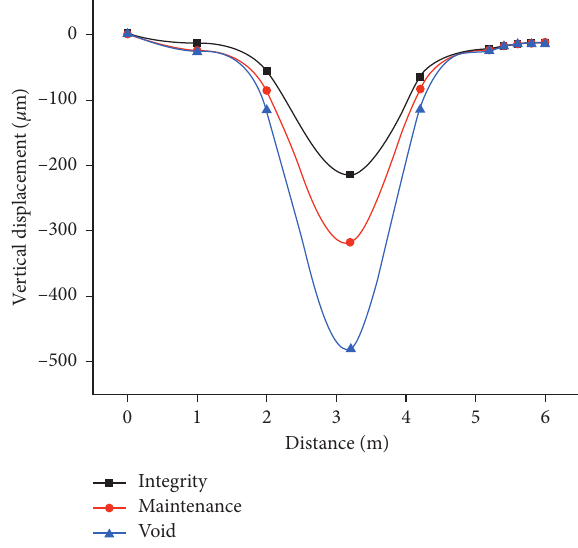
Figure 16: Comparison analysis diagram of vertical displacement under three working